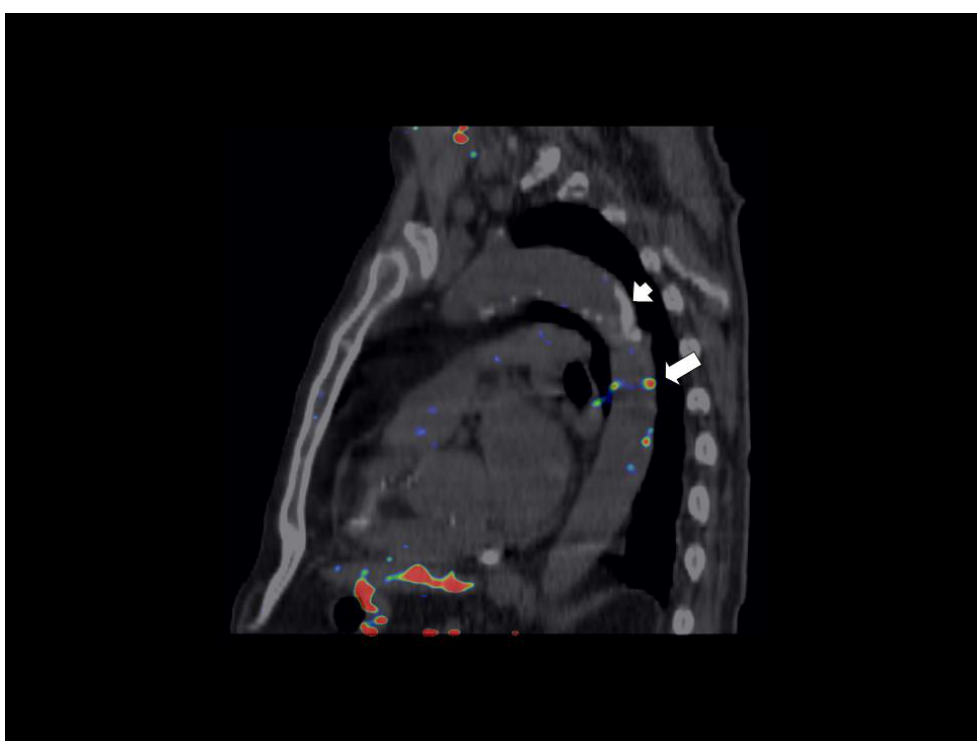
Figure 3. Representative 18 F-FDG-PET/CT image of thoracic aorta showing a big focal calcification ( arrowhead ) not related to significant 18 F-FDG uptake (TBR max = 1.3). In the descending aorta, an active focal 18 F-FDG uptake ( arrow ) is also shown (TBR max = 1.8). Abbreviations: 18 F-FDG-PET/CT = 18 F-fluorodeoxyglucose-positron emission tomography/computed tomography; TBR = target to background ratio. Table 3. Relation between atherosclerotic features and cystatin C values. Univariable and adjusted odds ratio* for the highest cystatin C group.